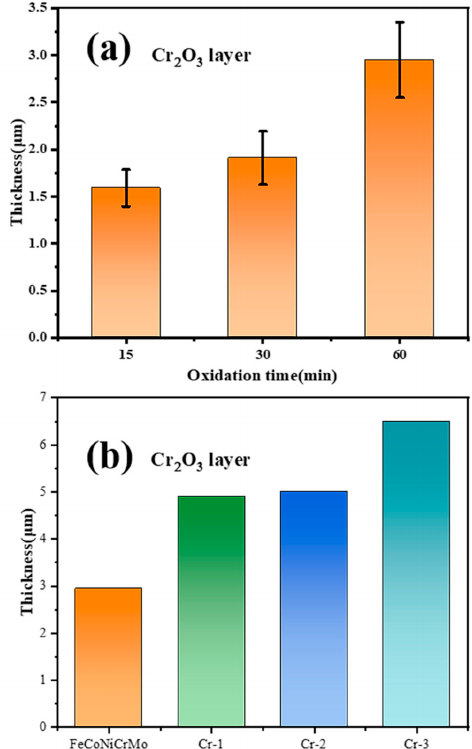
Figure 10. ( a ) The thickness of the Cr 2 O 3 layer on the FeCoNiCrMo coatings after oxidation at 1100 ◦ C for 15 min, 30 min, and 60 min in a steam environment, and ( b ) the thickness of the Cr 2 O 3 layer on the pure Cr coatings after oxidation for 60 min: Cr-1 [36], Cr-2 [37], and Cr-3 [38].